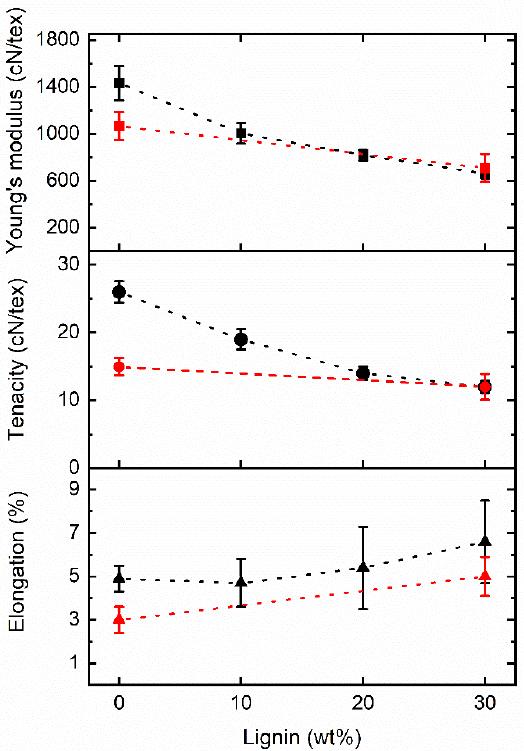
Figure 4. Tensile properties of the precursors spun with Systems S (black) and P (red) vs. lignin content.